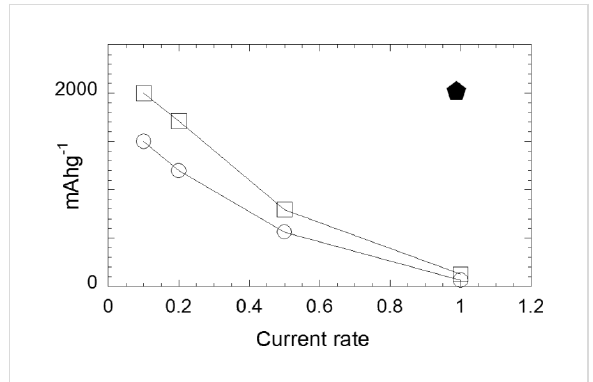
Figure 19: Capacities of a MgH 2 electrode obtained after three absorptions of hydrogen and then ground for 4 h with 10% of C t , z carbon as a function of the current rate (number of Li exchange per hours) open squares: discharge capacity, open circles: charge capacity; black pentagon: discharge capacity of a MgH 2 thin film of 200 nm